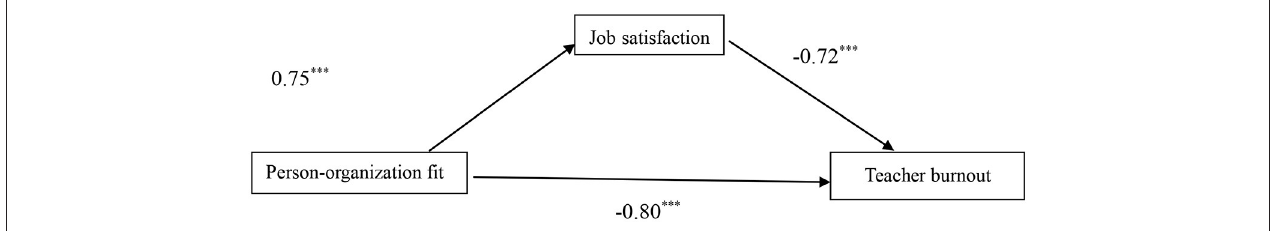
FIGURE 1 | The mediation model of job satisfaction on the relationship between person-organization fit and teacher burnout. *** p < 0.001.